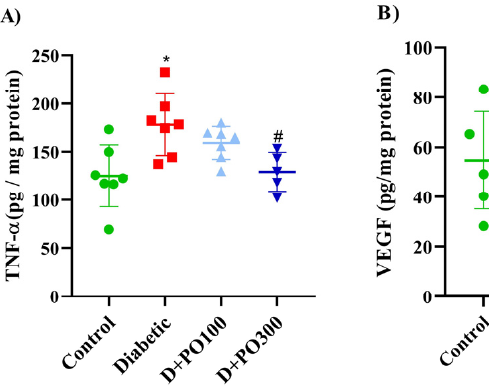
data are presented as mean ± SD. A one-way ANOVA test was carried out with the following Tukey–